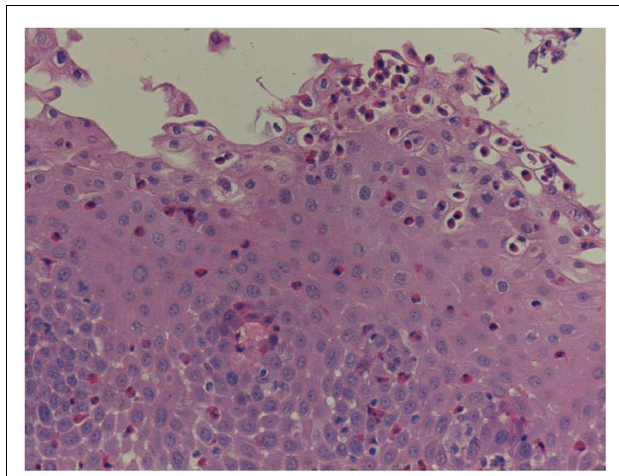
FIGURE 2 | Histology of EoE with marked infiltration of eosinophils in the mucosa .